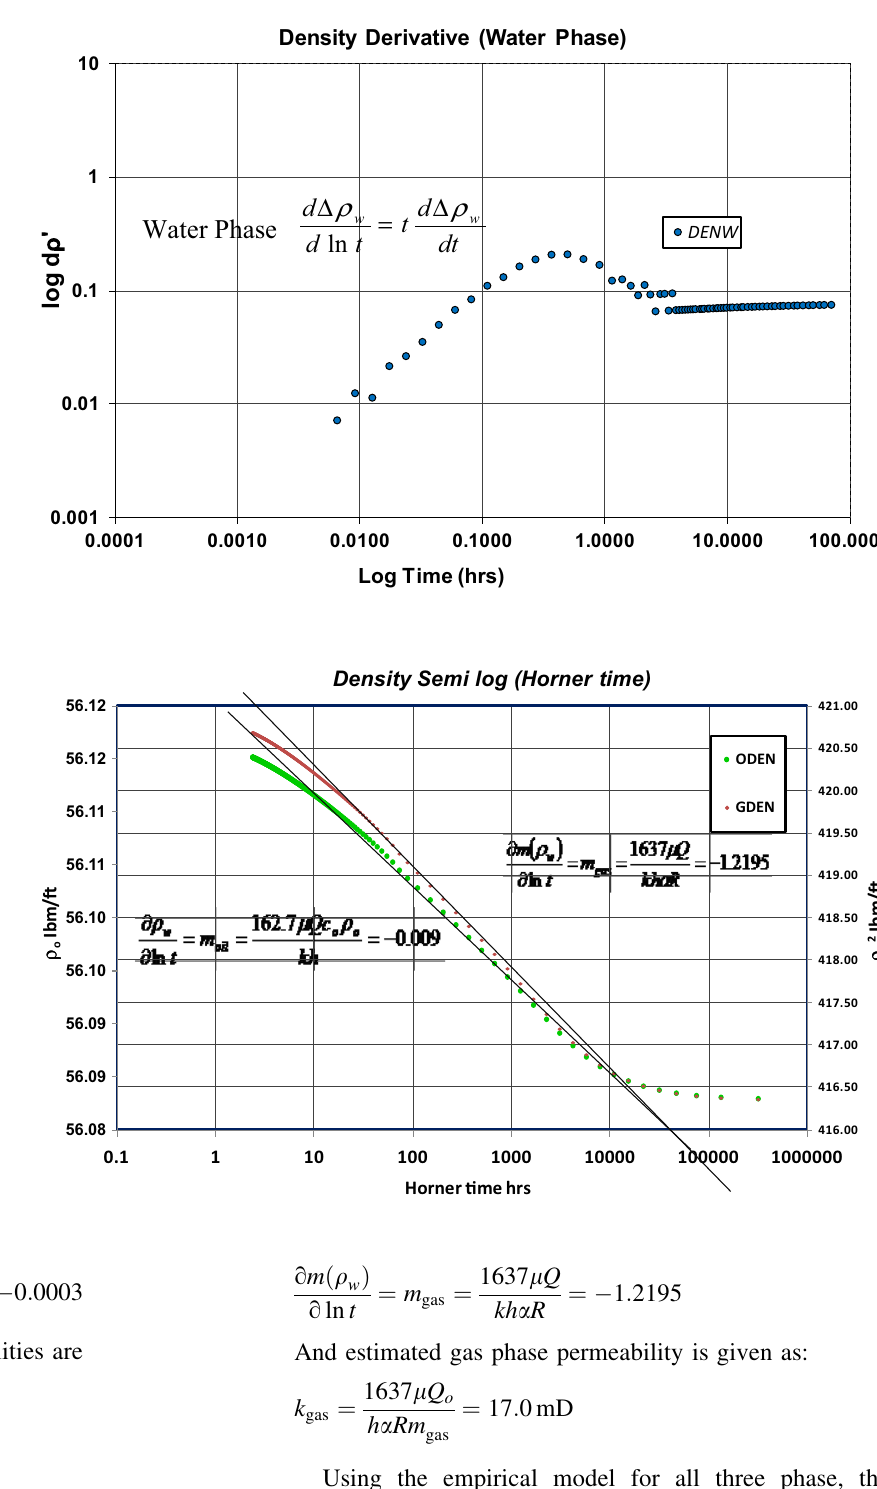
Fig. 14 Fluid phase (water)